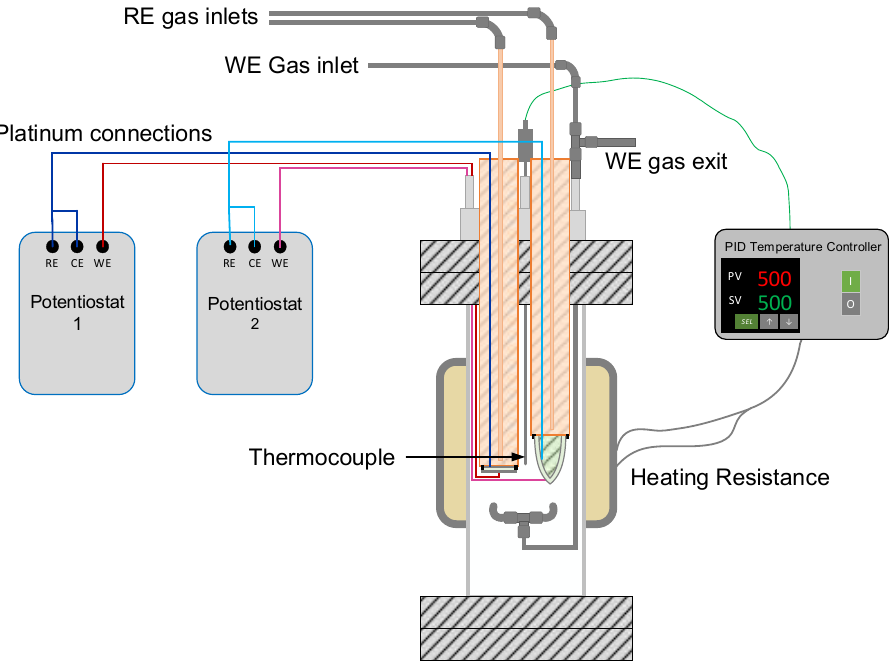
Figure 3. Schematic representation of the experimental setup for electrochemical measurements. WE: working electrode; RE: reference electrode; CE: counter-electrode; PV: process value; SV: set value; and PID: proportional-integral-derivative.